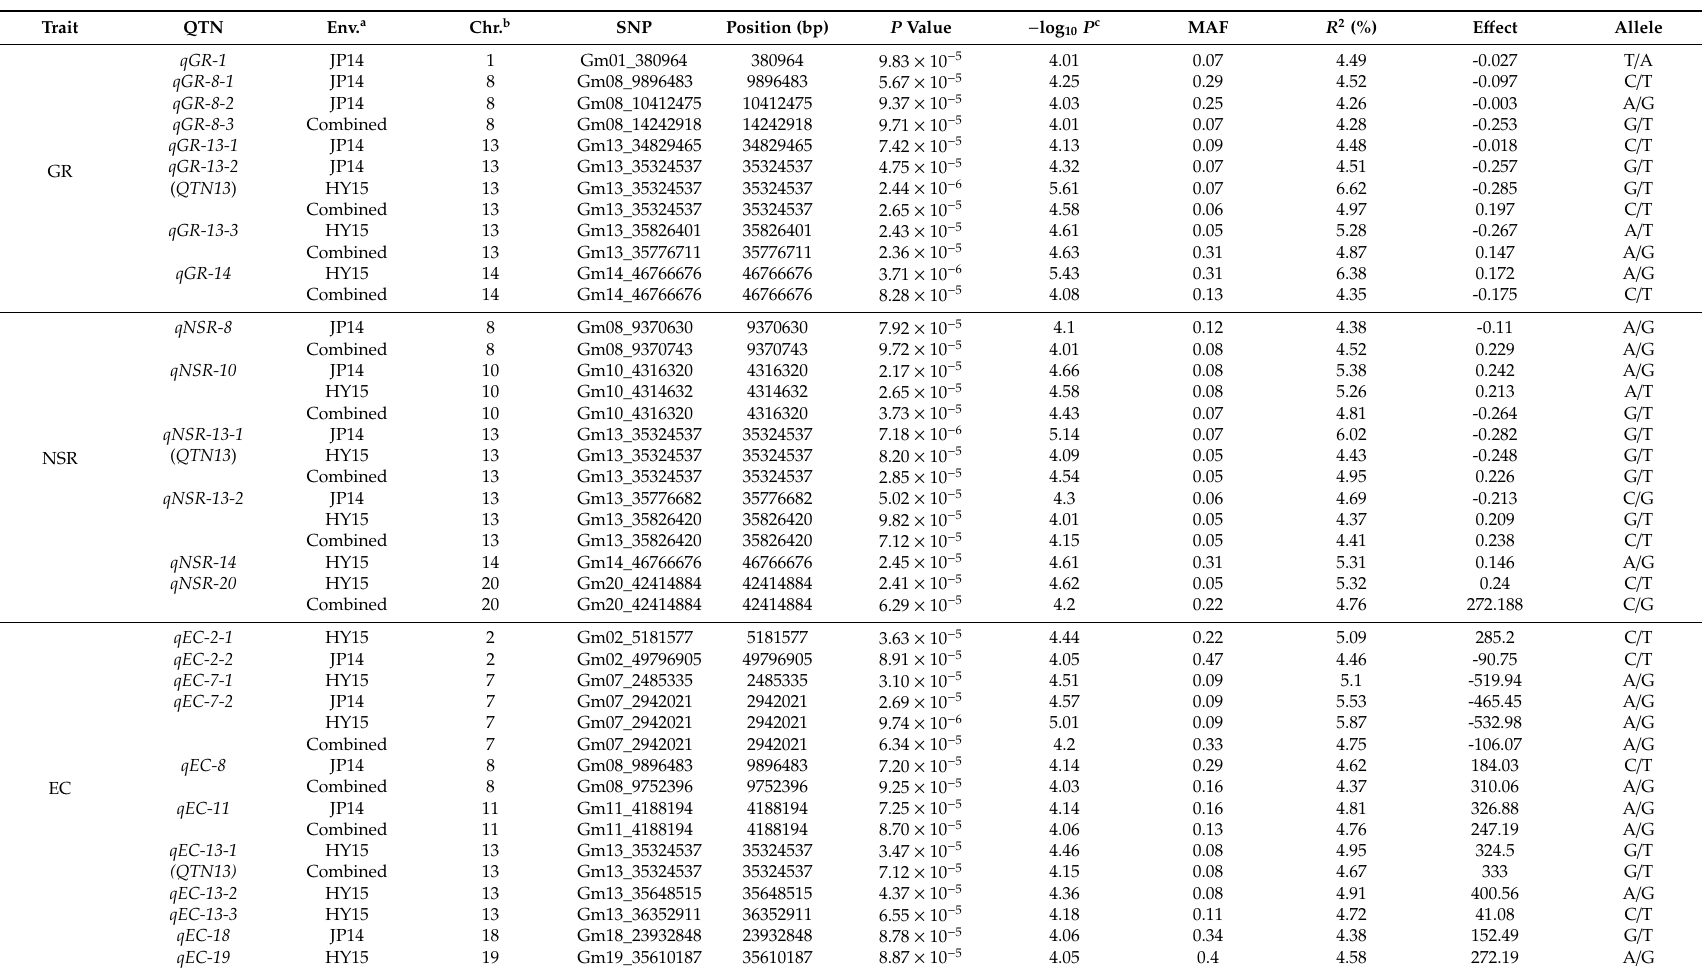
Table 2. Quantitative trait nucleotides (QTNs) associated with germination rate (GR), normal seedling rate (NSR) and electric conductivity (EC) via MLM.